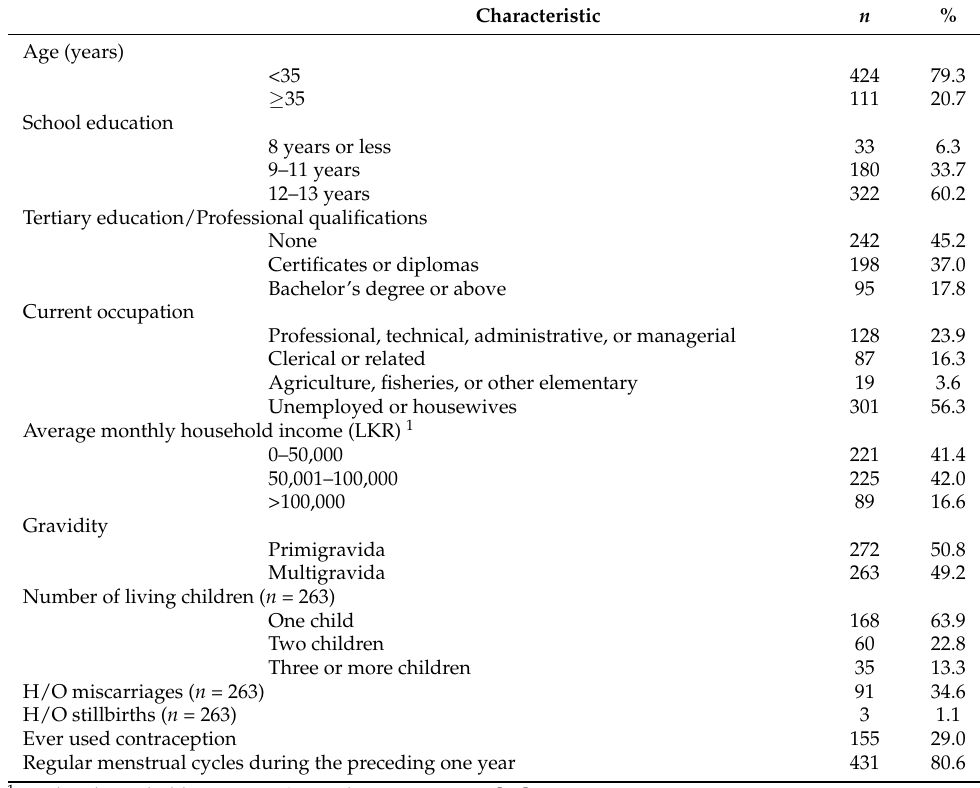
Table 1. Basic socio-demographic and reproductive health characteristics of the cohort at baseline ( n = 535).